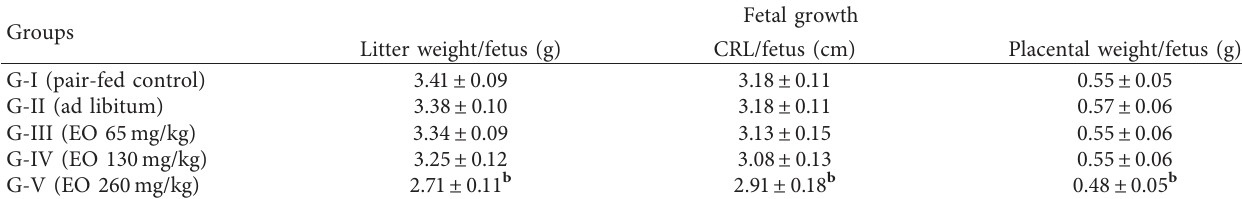
Table 6: Mean fetal growth following treatment with essential oil of Thymus schimperi in the day 20 experiment. Groups